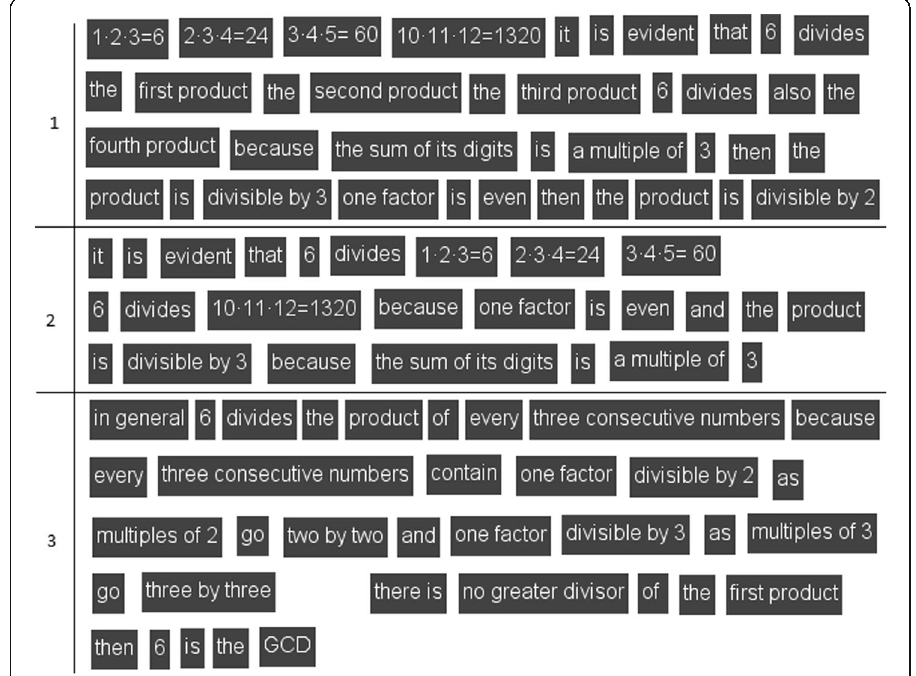
Fig. 5 Language tiles of the student ’ s